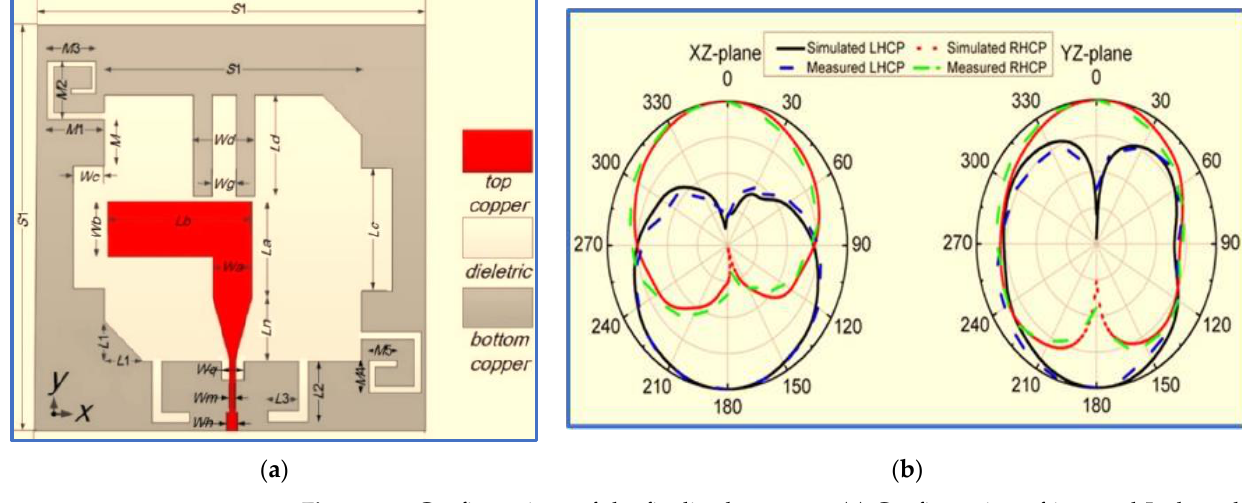
Figure 16. Configurations of the finalized antenna. ( a ) Configuration of inverted L-shaped slot antenna. ( b ) Simulated and measured antenna radiation patterns at 5.9 GHz [99].